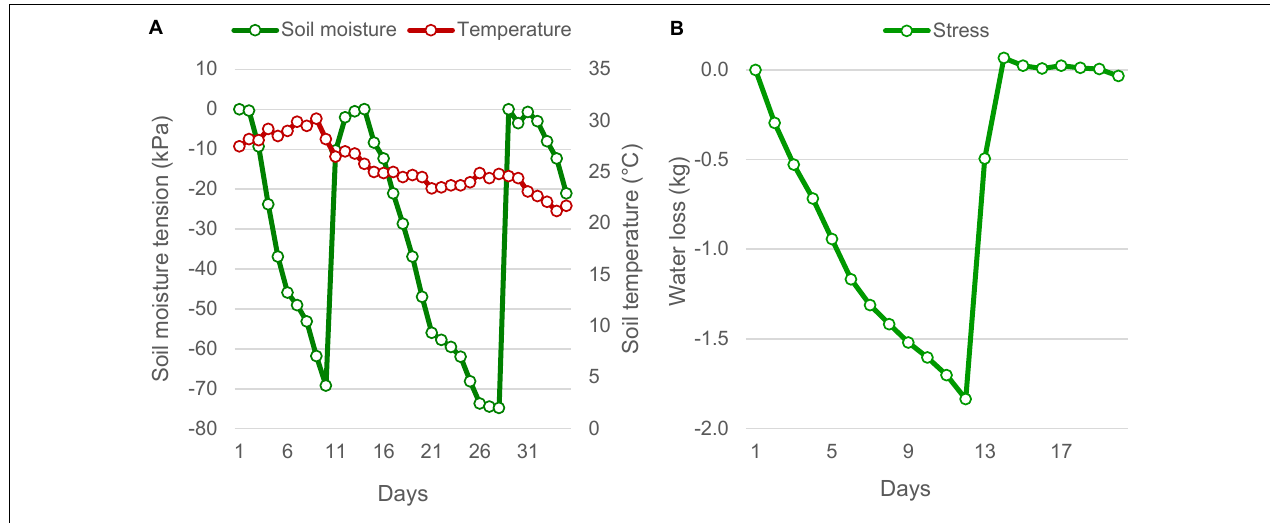
FIGURE 1 | Soil moisture status under stress in the field and pot culture experiments. (A) In the field, soil moisture depletion was determined by the increasing soil moisture tension, measured using tensiometers. The soil moisture tension reached below -70 kPa twice during the reproductive stage, which forced lifesaving irrigations. Average ambient air temperature during the period did not vary much. It took an average of 9.5 days to reach the maximum stress from field capacity. (B) The pot culture under phenomics also was subjected to similar stress, the moisture depletion was measured as the falling weight of the pots. When the pots lost 1,840 g of water on the eleventh day, the plants experienced severe stress as that seen in the field, which was followed by lifesaving irrigation on the twelfth day of imposing